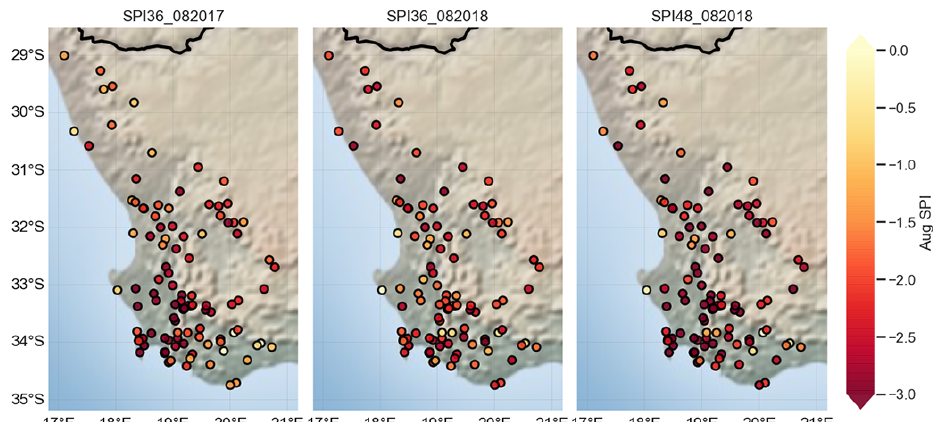
Figure 4. Long-term (36- and 48-month, as indicated) SPI at the end of August of the years indicated. Note the difference in scale to Fig.